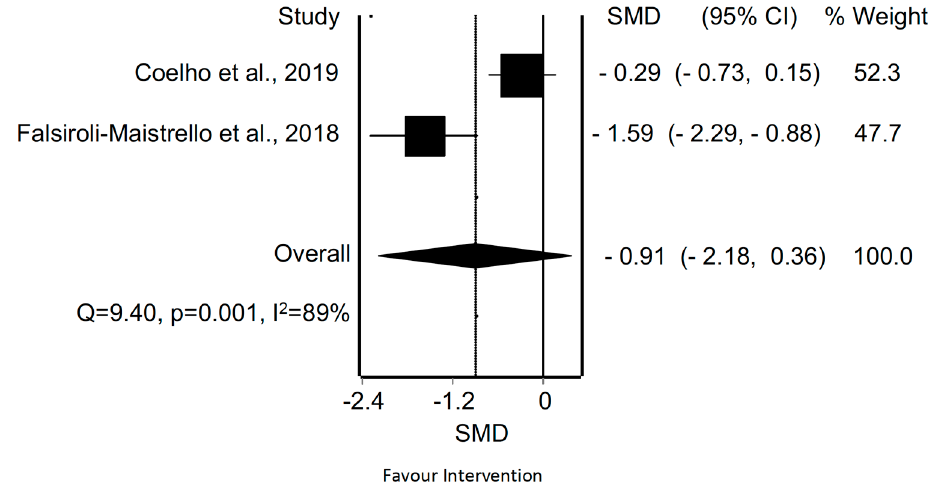
Figure 10. Synthesis forest plot for the frequency of symptoms in patients with tension-type headache treated with manual therapy. The forest plot summarizes the results of included studies (review size, standardized mean differences [SMDs] and weight). The small boxes with the squares represent the point estimate of the effect size and sample size. The lines on either side of the box represent a 95% confidence interval